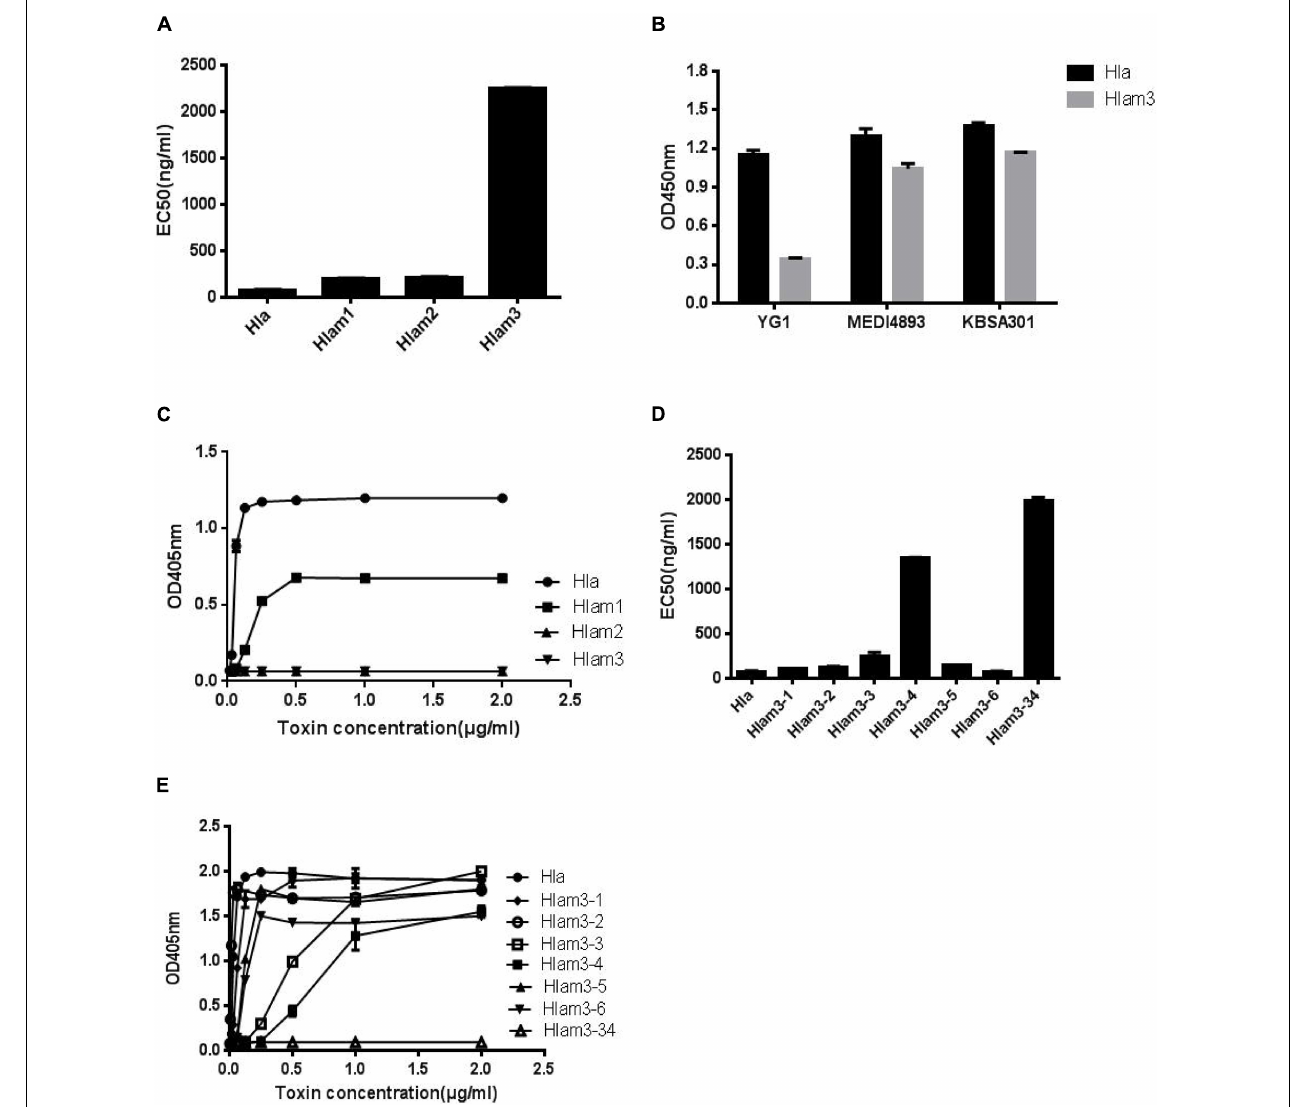
FIGURE 6 | Mapping the epitope of Hla recognized by YG1 using Hla variants. (A,D) The binding affinity of YG1 to Hla and its mutations was determined by ELISA. Hla or Hla mutants were coated onto 96-well plates, and YG I was added at various concentrations. Bound YG I was detected using horseradish peroxidase (HRP)-conjugated goat anti-human IgG. The EC50 value was calculated using GraphPad Prism Software. (B) The binding affinities of YG1, MEDI4893, and KBSA301 to Hla or Hlam3 were determined by ELISA. Hla or Hlam3 protein was coated onto 96-well plates, and antibodies were added at various concentrations. Bound IgG was detected using horseradish peroxidase (HRP)-conjugated goat anti-human IgG. (C,E) Effects of Hla and Hla mutants on the lysis of rabbit red blood cells. Serial dilutions of Hla or Hla mutants (0, 0.015625, 0.03125, 0.0625, 0.125, 0.25, 0.5, 1, and 21 µ g/mL) were incubated with rabbit red blood cells for 1 h at 37 ◦ C. The samples were centrifuged, and the absorbance of the supernatants was measured at 405